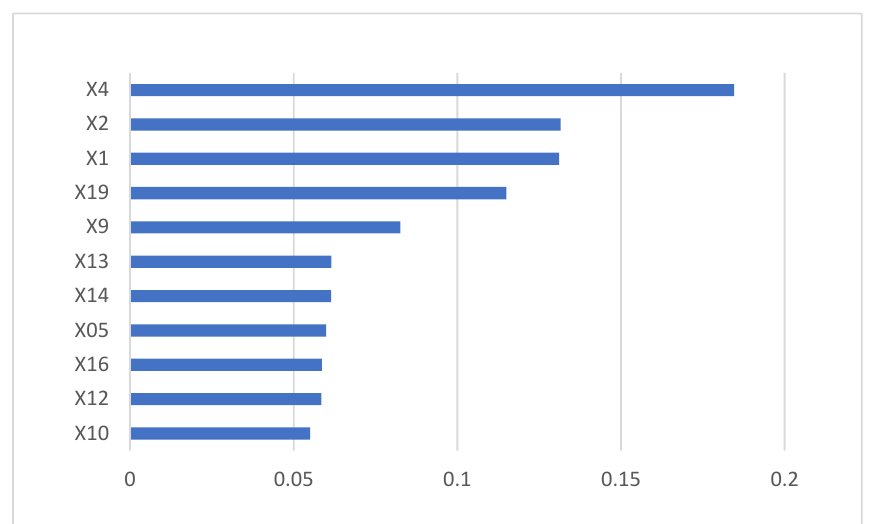
Figure 4. The Gini index of final indexes.